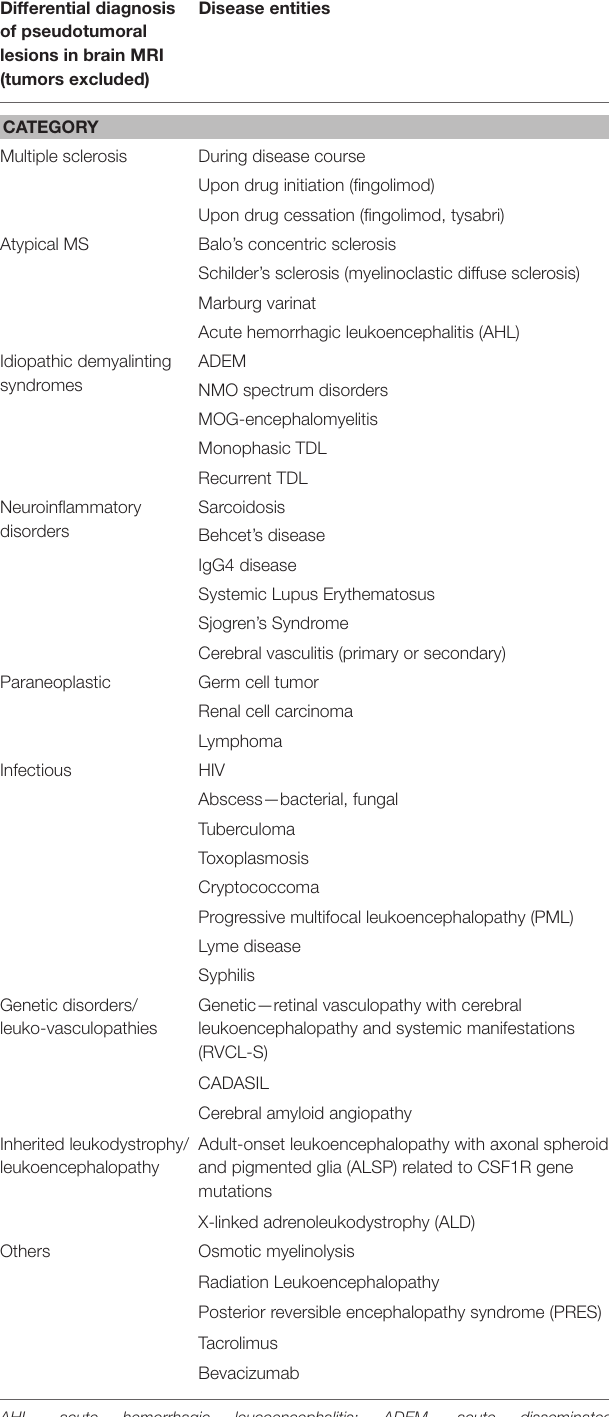
TABLE 1 | Differential diagnosis of pseudotumoral lesions in brain MRI (tumors excluded). Differential diagnosis of pseudotumoral lesions in brain MRI (tumors